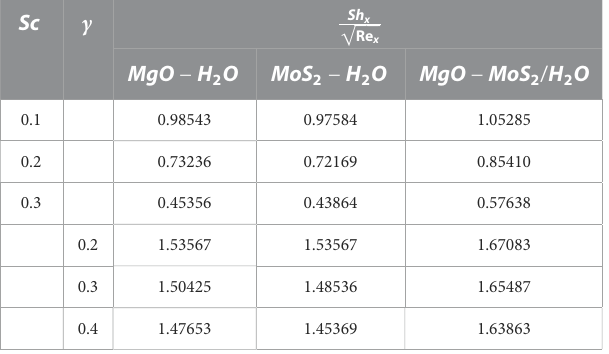
TABLE 4 In fl uence of γ and Sc on the Sherwood